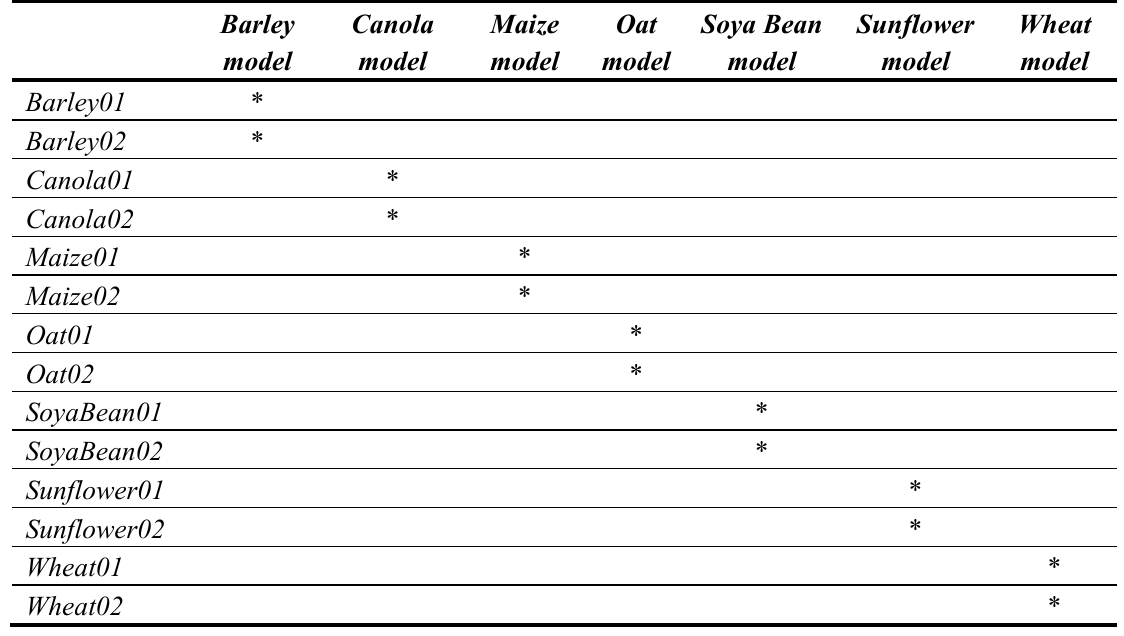
Table 2. Classification table of the evaluation samples (samples of each seed type numbered 01 and 02). The table is marked to show in which of the PCA models (columns) the evaluation samples (rows) were best fitted.